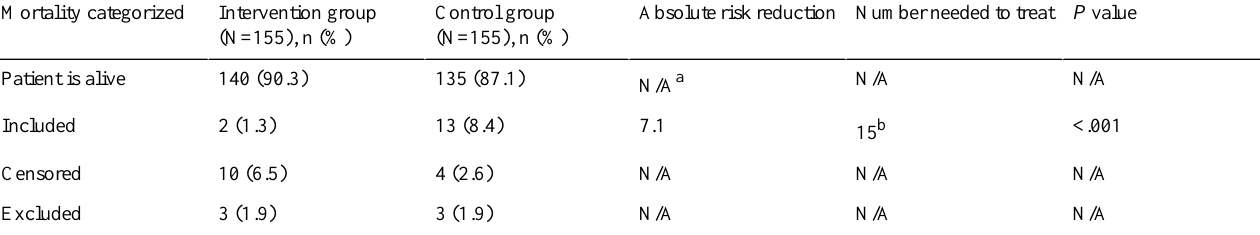
Table 6. Categorization of mortality, ARR, and